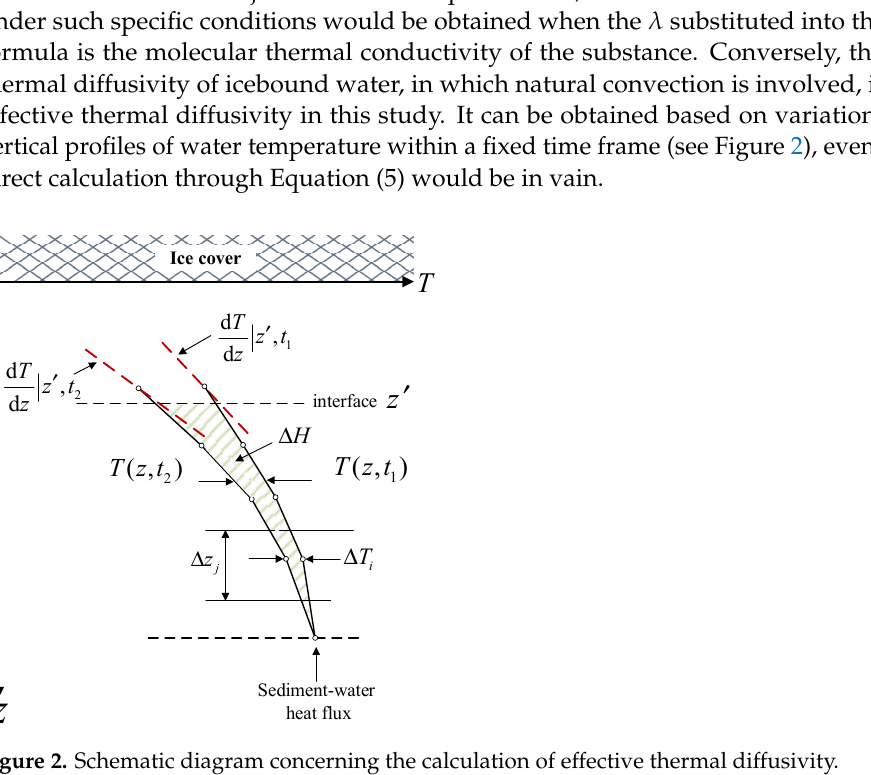
Figure 2. Schematic diagram concerning the calculation of effective thermal diffusivity.